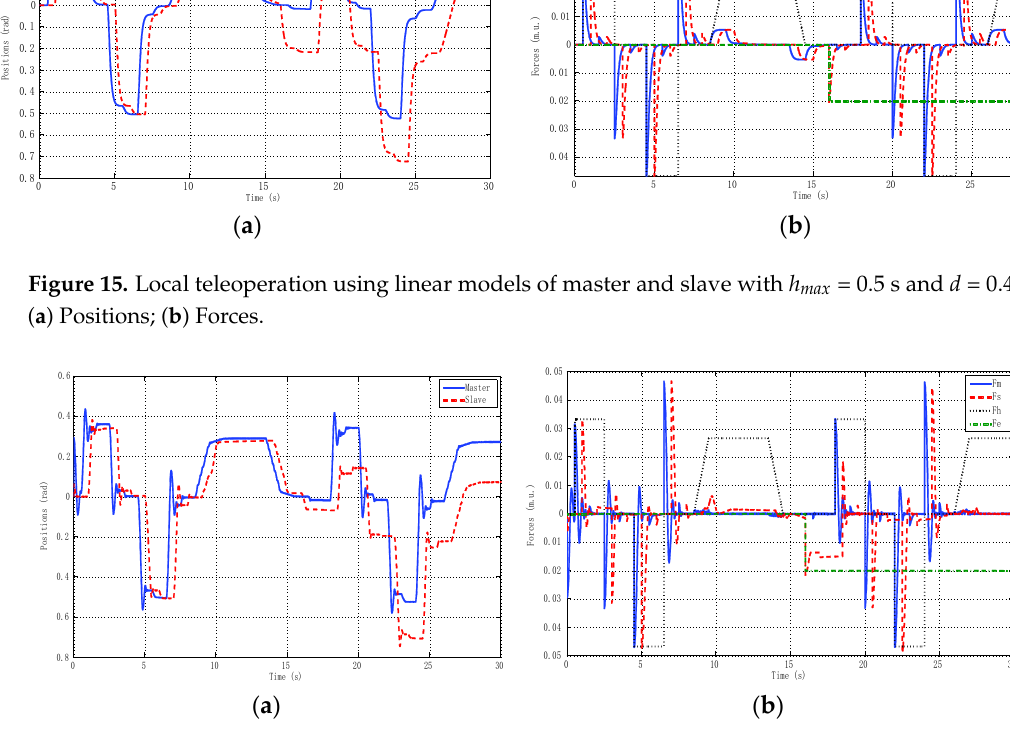
Figure 17. Remote teleoperation between Vigo and Manchester using linear models of master and slave. ( a ) Positions; ( b ) Forces.